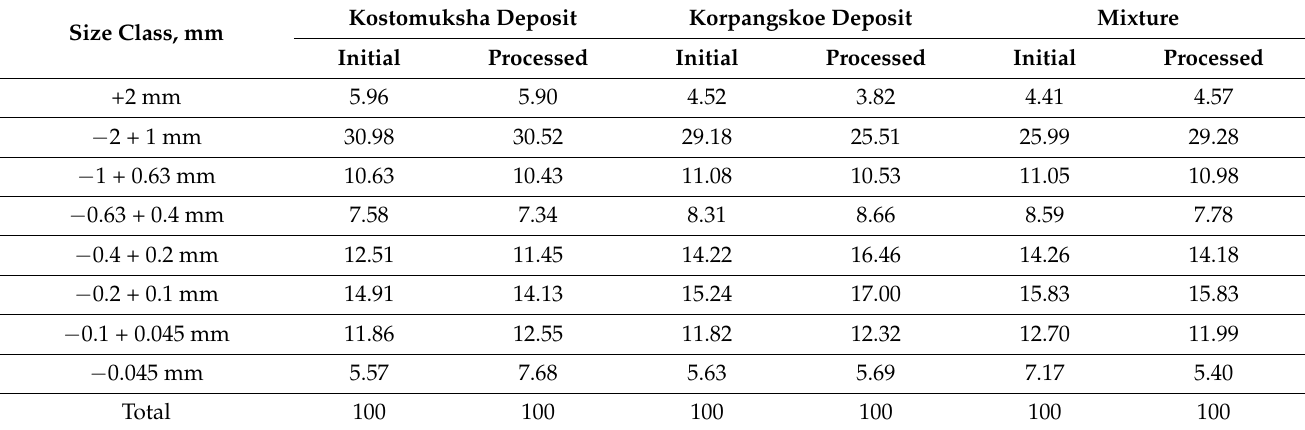
Table 8. Granulometric composition of the final crushing product.